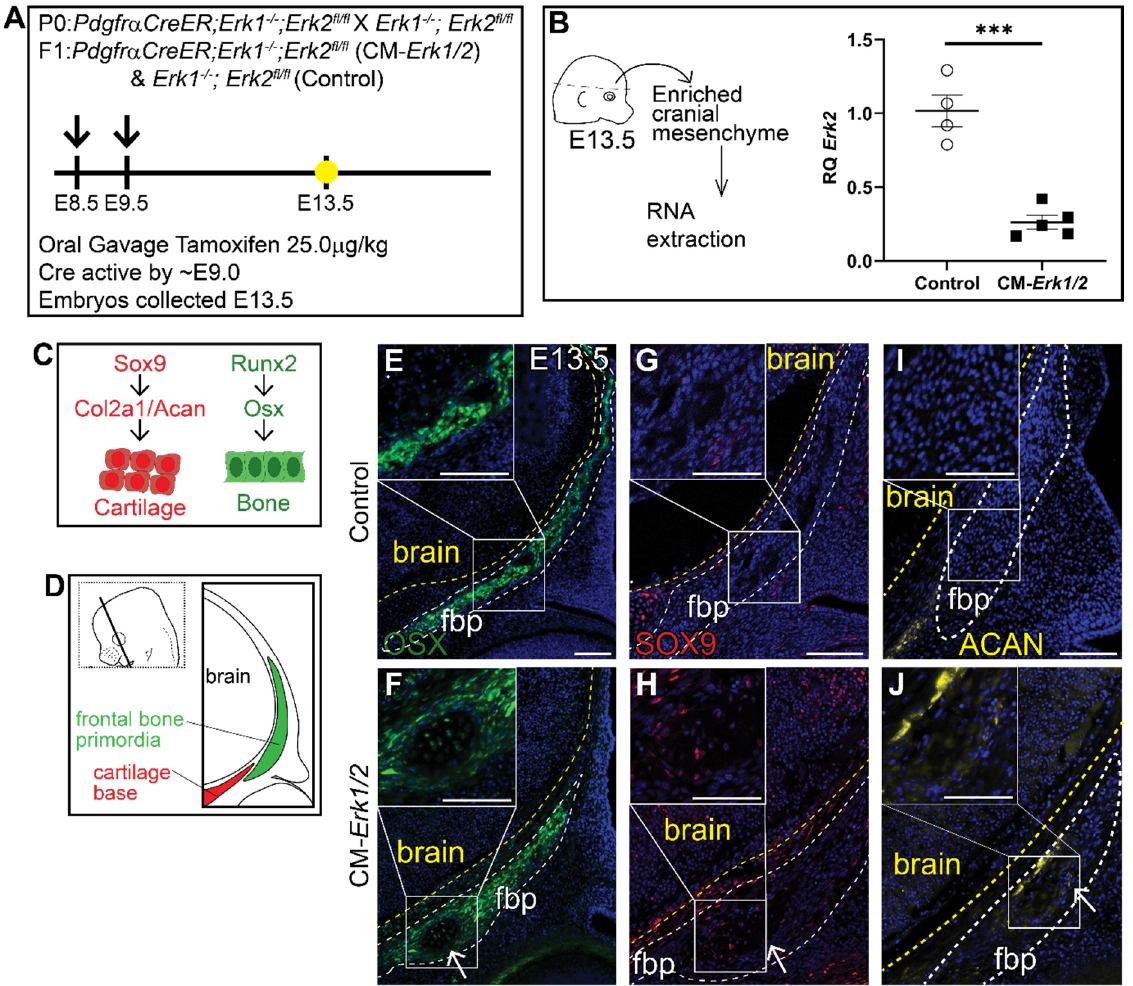
Figure 1. Loss of ERK1/2 results in diminished expression of OSX, and ectopic expression of chondrocyte fate markers at E13.5. Schematic depicting the gavage regimen and timing of deletion of Erk2 ( A ). ( B ) Schematic depicting the work flow and tissue source for the RNA analysis, RT-qPCR analysis depicting the relative quantity of mRNA transcripts for Erk2 demonstrating deletion efficiency of gavage regimen. p (***) = 0.0002. Bone and cartilage cell fate and marker schematic ( C ) and orientation and plane of specimens ( D ). Immunofluorescence for calvarial progenitor marker, OSX ( E , F ), and chondrocyte markers, SOX9 ( G , H ) and Aggrecan (ACAN) ( I , J ) at E13.5. Arrows indicate ectopic cartilage formation. fbp, frontal bone primordia; n = 3–5